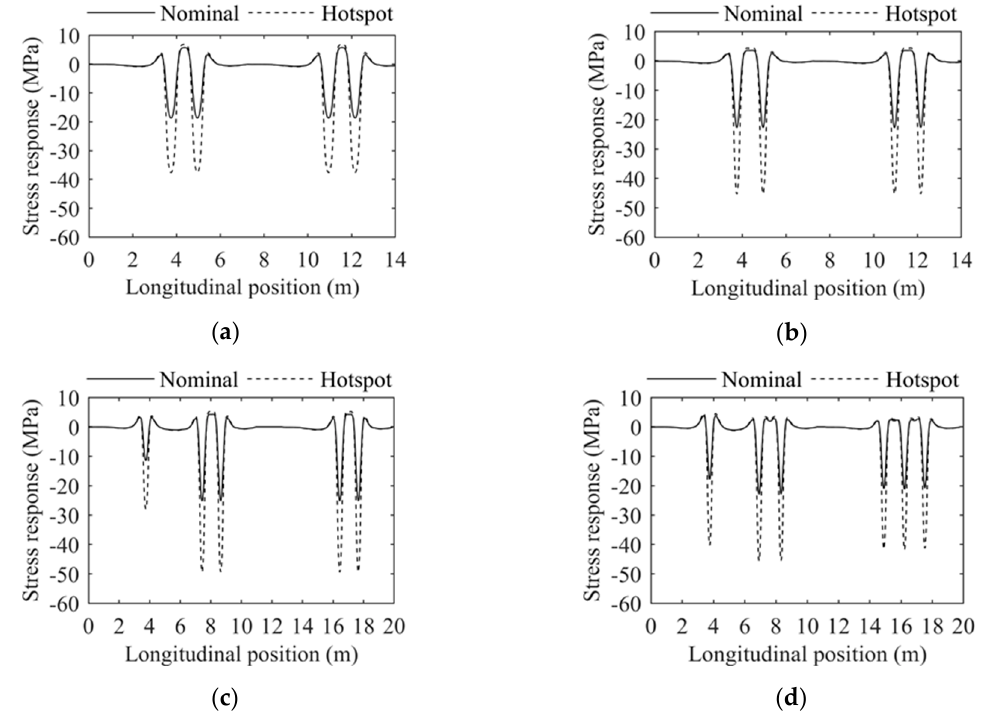
Figure 12. The most critical stress history of the joint U12 L under different models: ( a ) JTG; ( b ) EC1; ( c ) AASHTO; ( d ) Observation model.